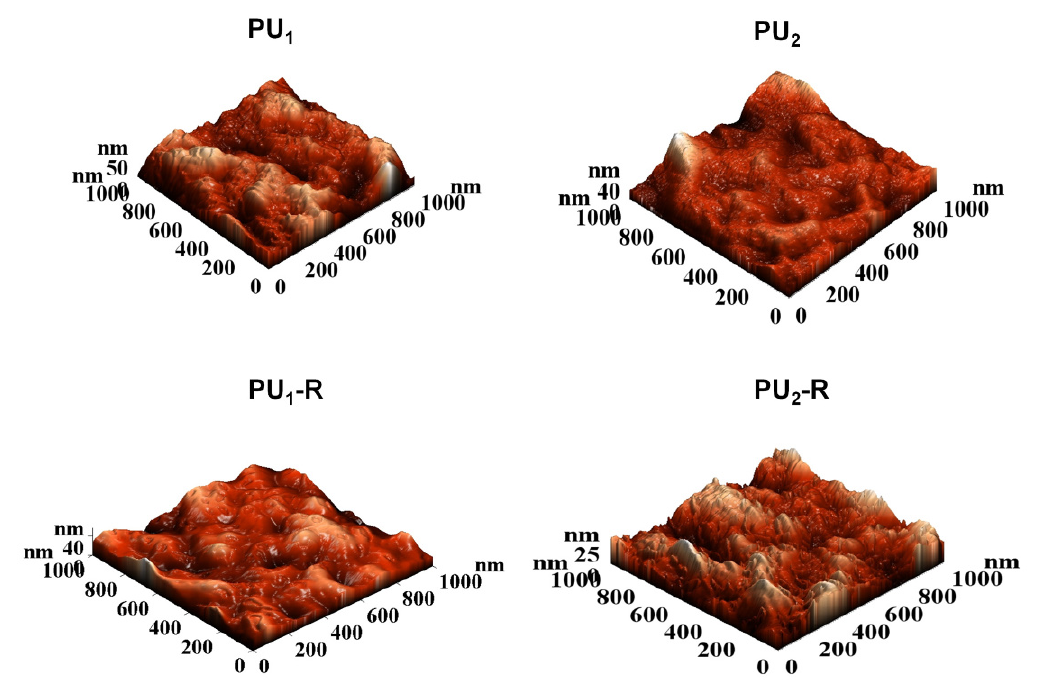
Figure 5. Atomic force microscopy images (AFM).